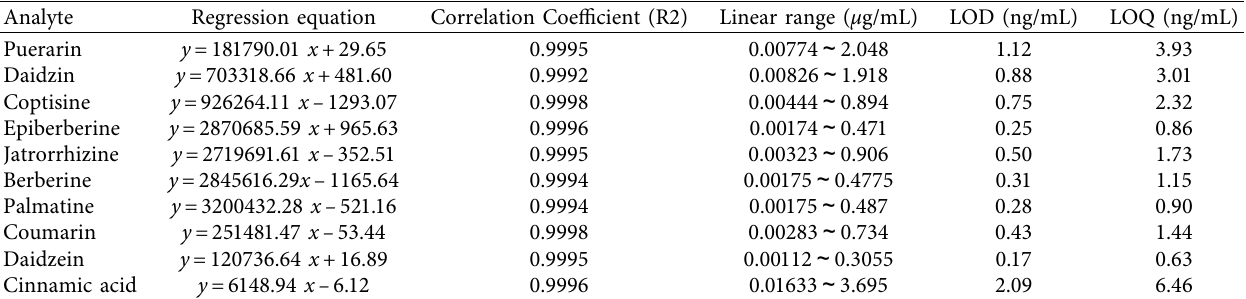
Table 2: Regression equation, correlation coefficient, linear range, LOD, and LOQ of 10 components in UHPLC-QQQ-MS. Analyte Regression equation Correlation Coefficient